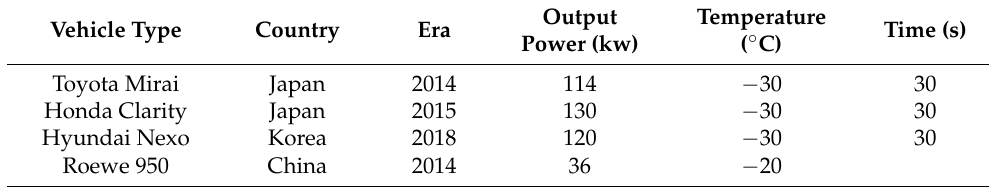
Output Temperature Time (s) Power (kw) ( ◦ C)